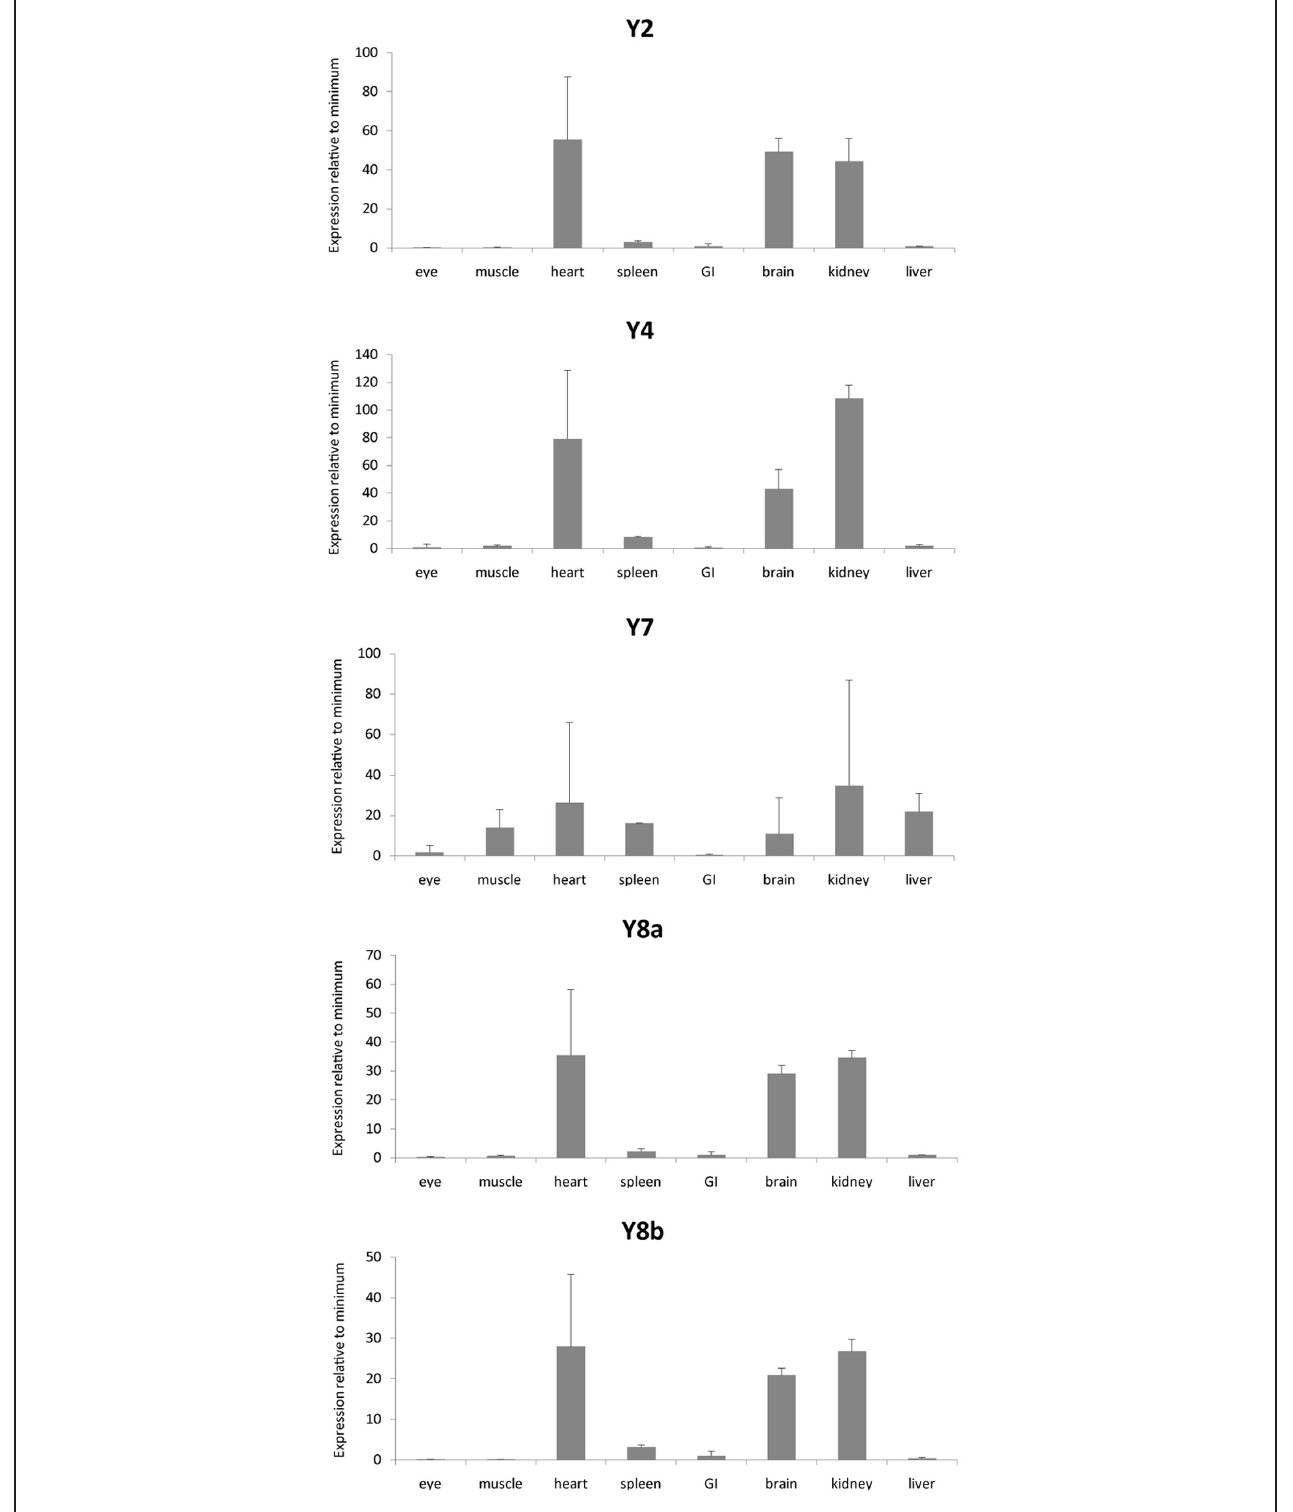
FIGURE 4 | Expression data for neuropeptide Y receptors in a panel of eight zebrafish organs. Error bars display standard error of the mean. Normalized Ct values were used to calculate the relative expression values. For each transcript the tissue with the lowest